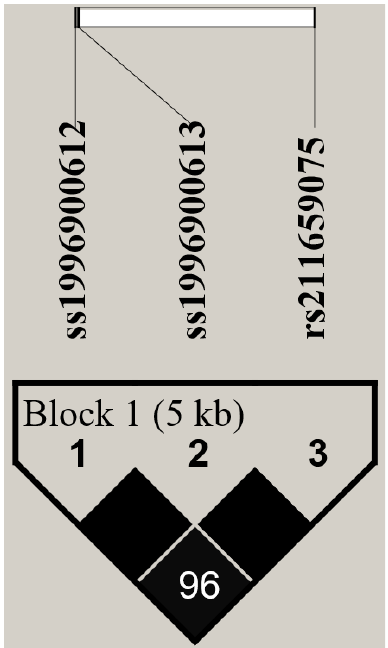
Figure 1. The haplotype blocks and pairwise linkage disequilibrium (LD) values (D’) for the UDP-galactose-4-epimerase (GALE) single nucleotide polymorphisms (SNPs). The values within boxes are pair-wise SNP correlation (D’), black boxes without numbers indicate complete LD (D’ = 1).